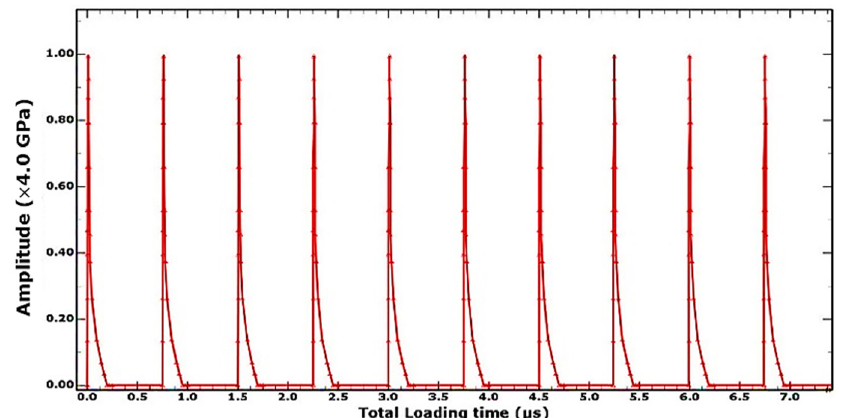
Figure 6. Single-explicit multiple-stepped analysis profile.